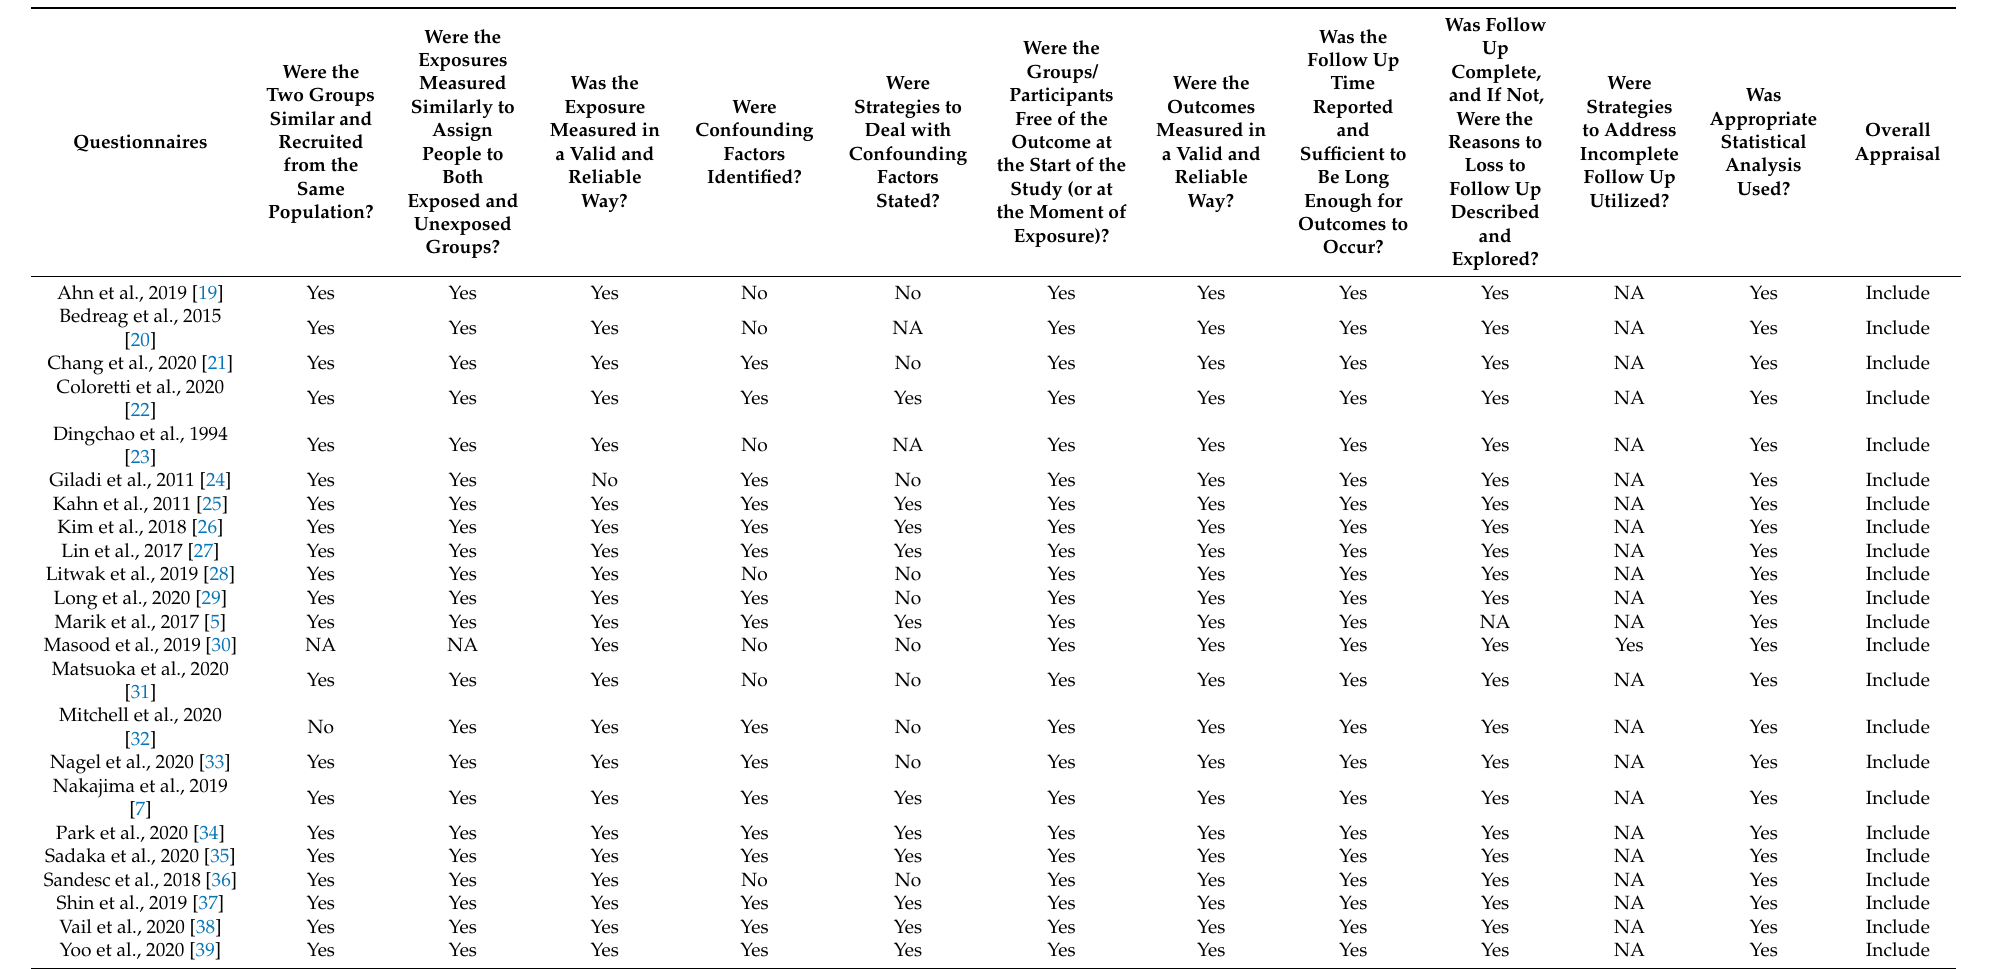
Table 1. JBI Bias